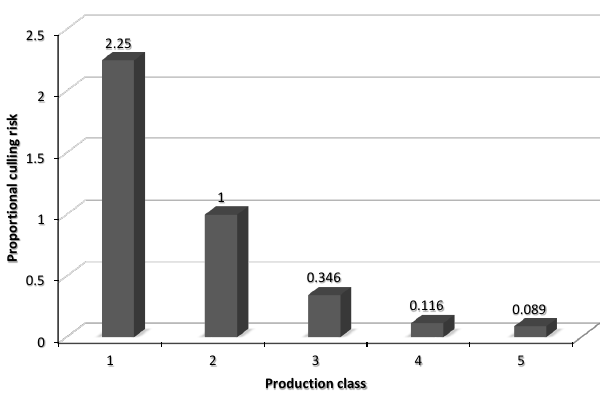
Figure 2. Relationship between proportional culling risk and milk production.